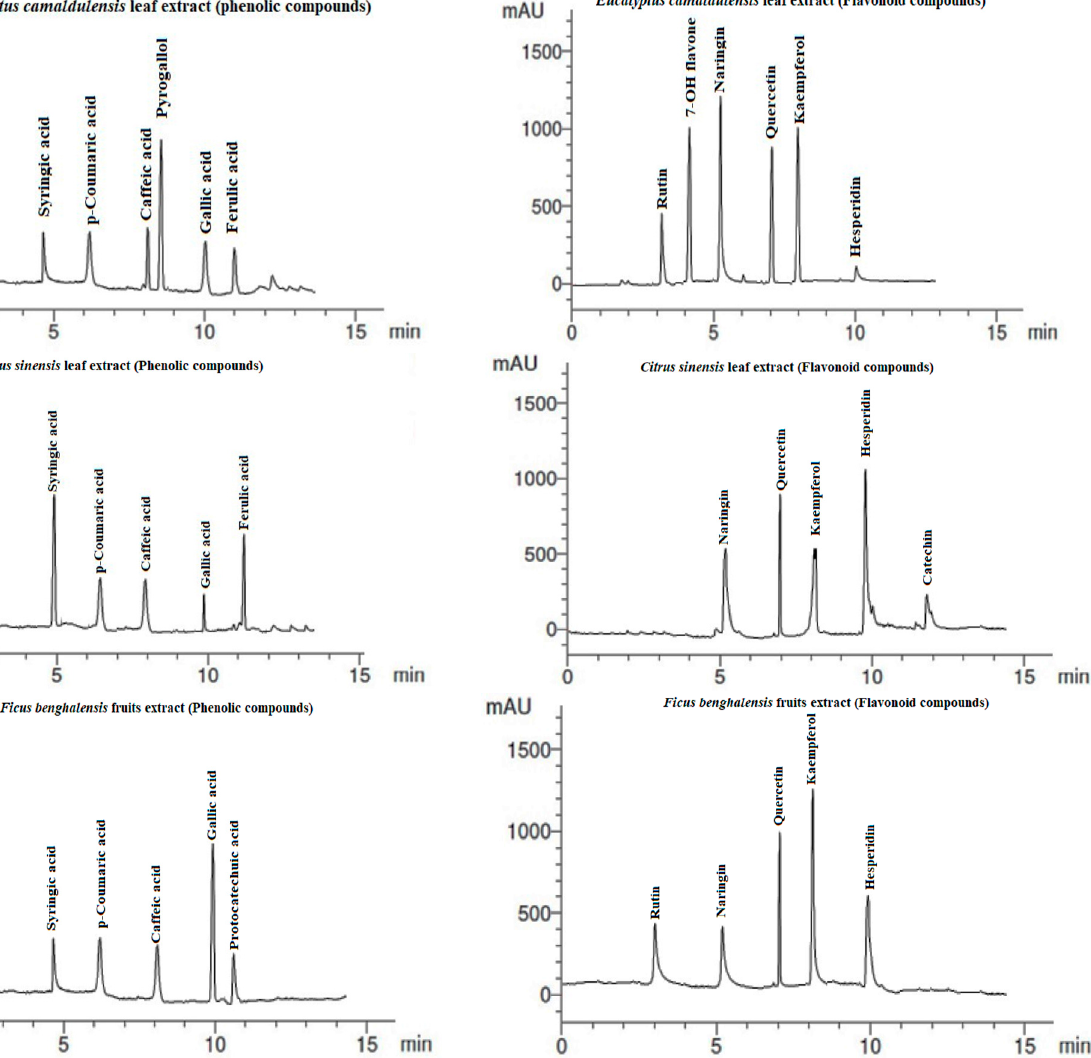
Figure 5. HPLC of phenolic and flavonoid compounds identified in water extracts from E. camaldulensis leaves, C. sinensis leaves, and F. benghalensis fruits.